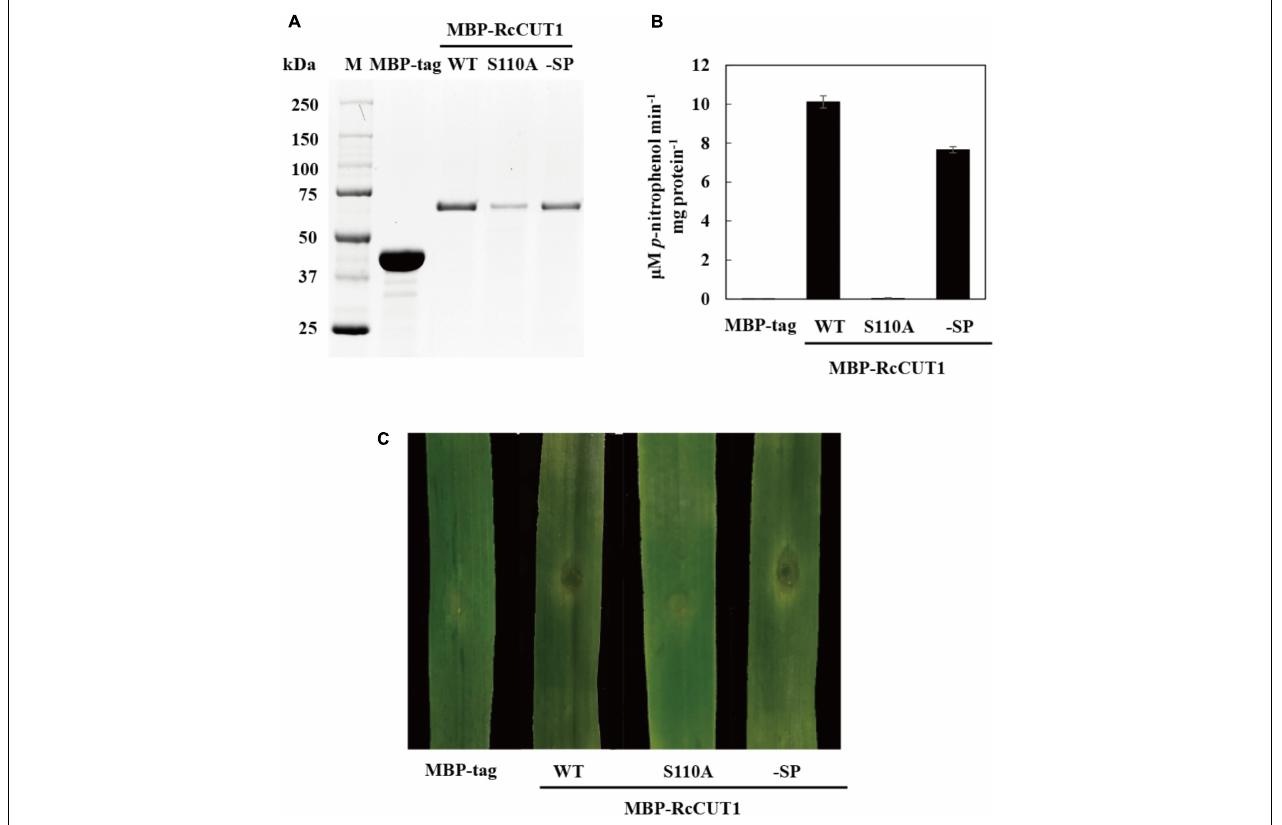
FIGURE 5 | The enzymatic activity is required for the cell death-inducing activity of RcCUT1. (A) Sodium dodecylsulphate-polyacrylamide gel electrophoresis (SDS-PAGE) of the purified enzymes of wild-type MBP-RcCUT1 and its mutants. MBP-RcCUT1 S110A, site-directed mutant; MBP-RcCUT1-SP, signal peptide deletion mutant; MBP-tag, as the check sample. (B) Enzyme activity of MBP-RcCUT1 variants were measured at 20 ◦ C using p -NPB as substrate. Standard errors are shown. (C) Detection of the cell death-inducing activities of MBP-RcCUT1 variants in wheat leaves.